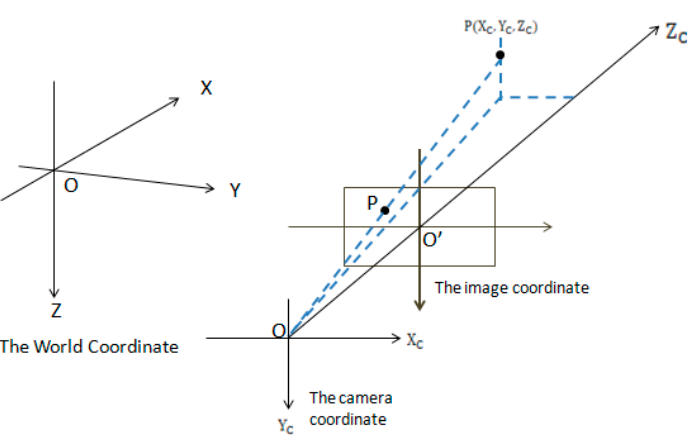
Figure 3. World coordinate system, image coordinate system, and camera coordinate system.